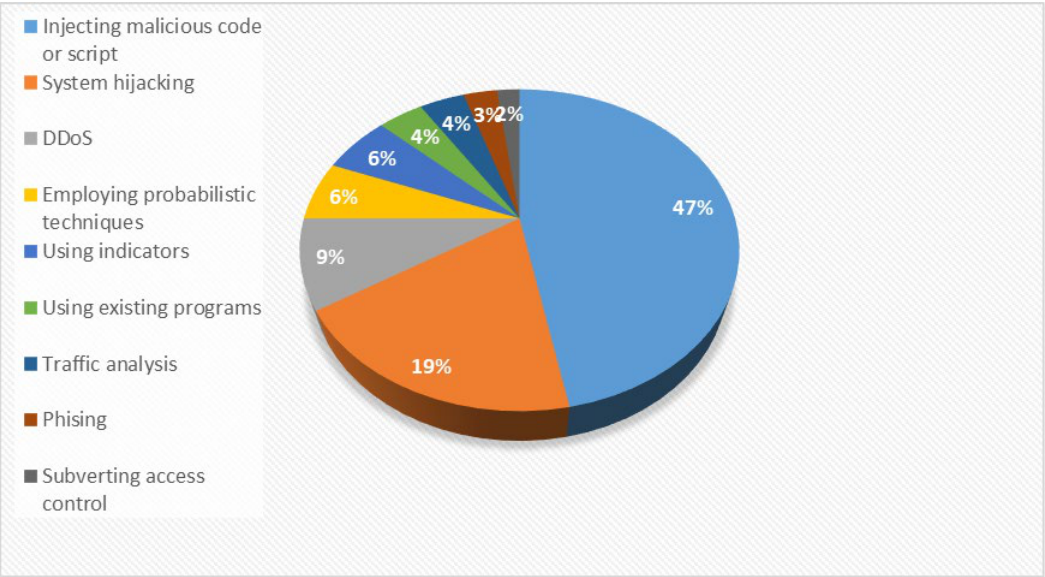
Figure 1. Data analysis of various security attacks on